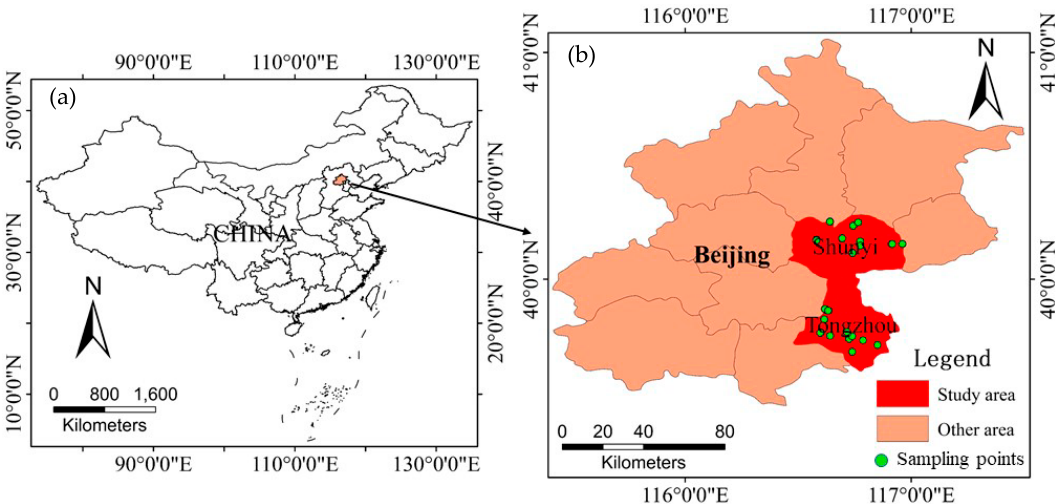
Figure 1. Study area: ( a ) Beijing in China; ( b ) Tongzhou and Shunyi districts in Beijing. Green dots are sampling points.